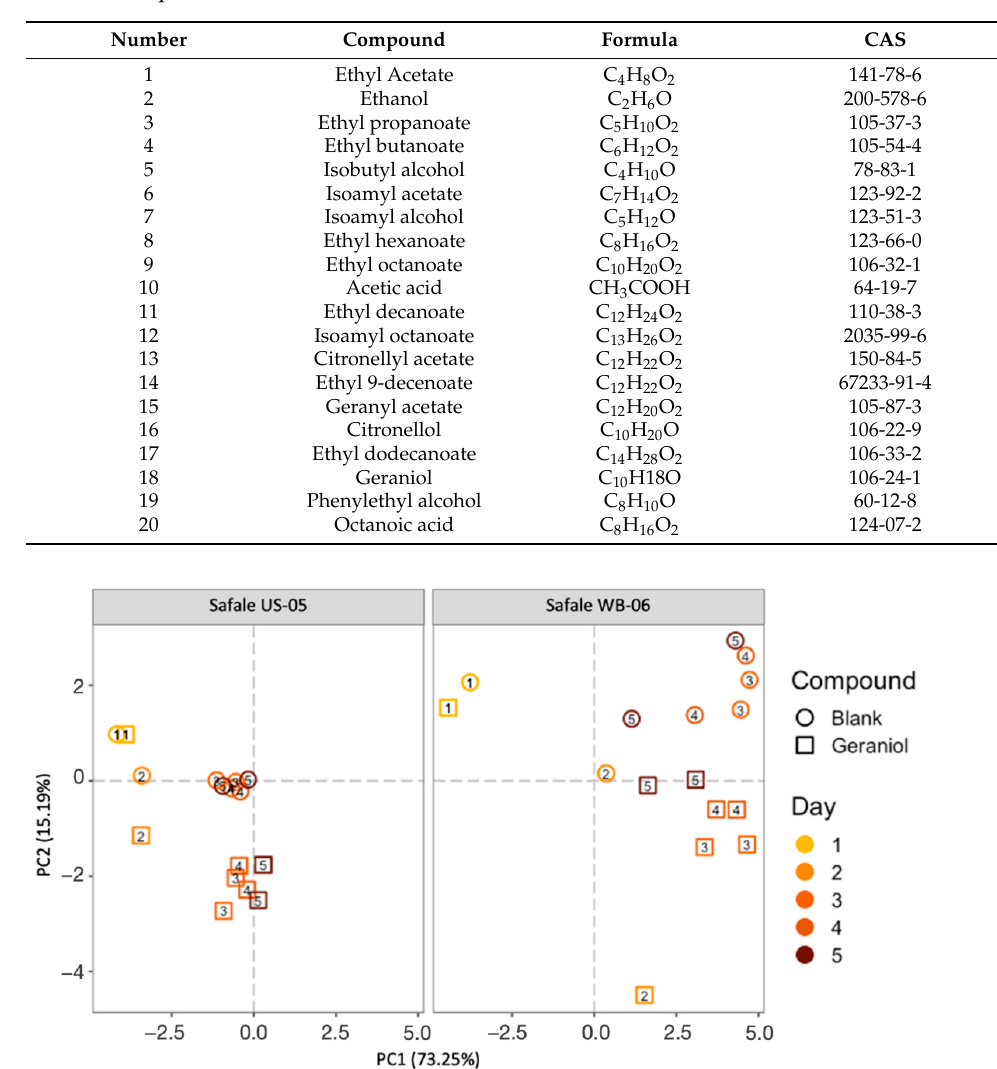
Table 4. Compounds detected at the end of fermentation with SPME-GC/MS.